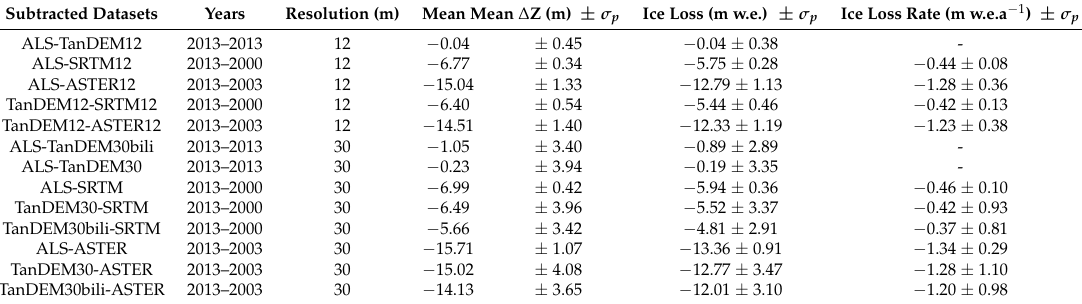
Table 3. Results of DEM subtraction and ice loss calculations for GA. σ c and σ u were calculated from ∆ Z histogram (Figures 5–7). σ p was calculated on stable area (SA; Table